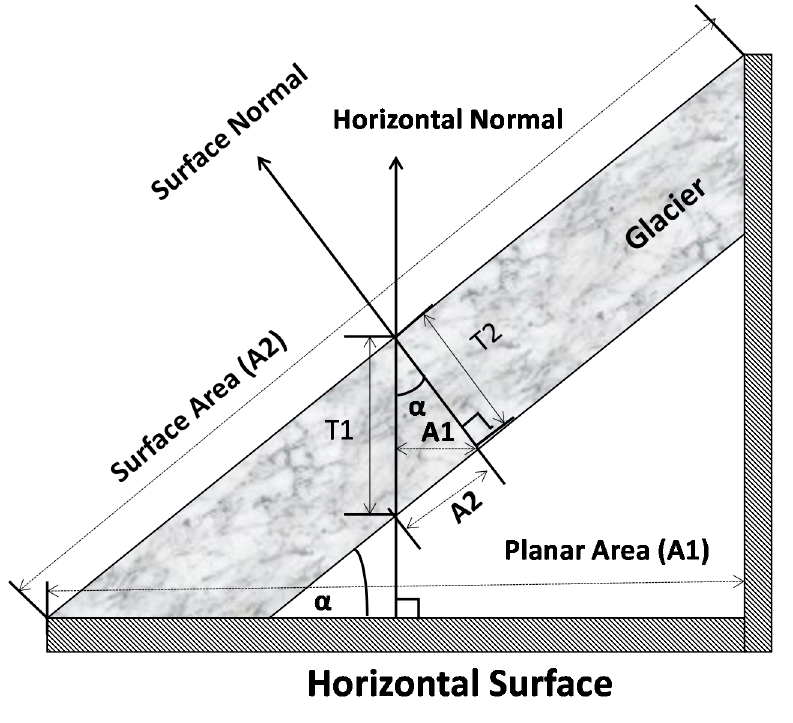
Figure 1. Schematic diagram of the definitions of glacier’s area (A) and thickness (T) in a longitudinal glacier profile.